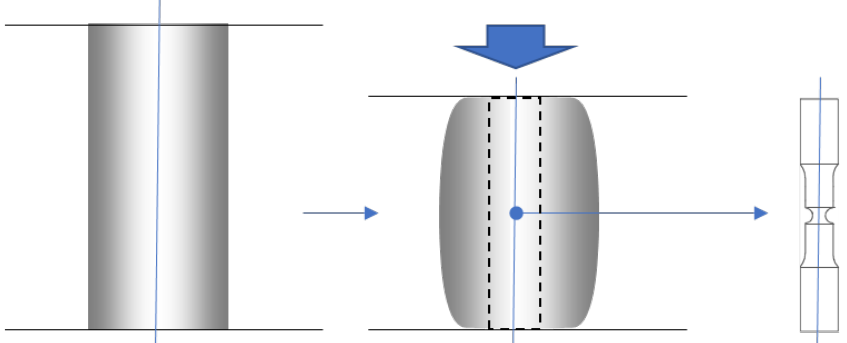
Figure 5. Schematics of tensile test after the compressive test.